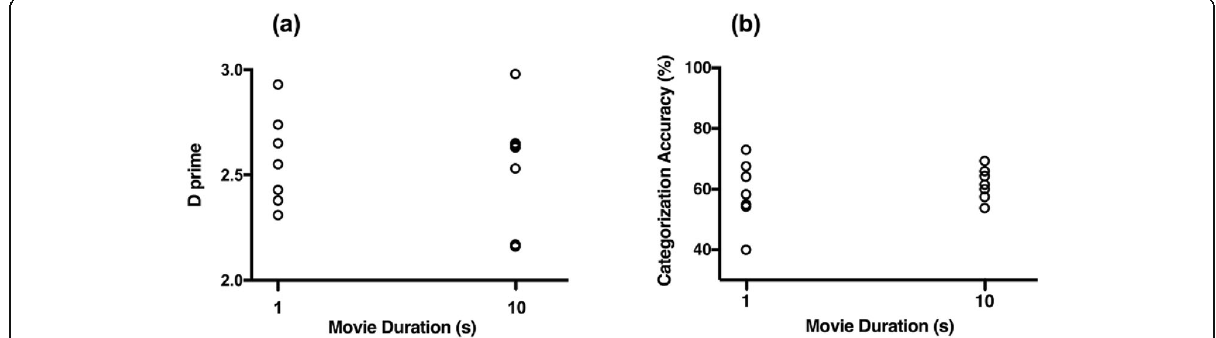
Fig. 3 Performance on the left ventricular function assessment task for 14 echocardiographers. Seven participants observed the movies for 1 s and seven participants for 10 s. Panel ( a ) illustrates D prime and ( b ) categorization accuracy. Each point represents an individual echocardiographers ’